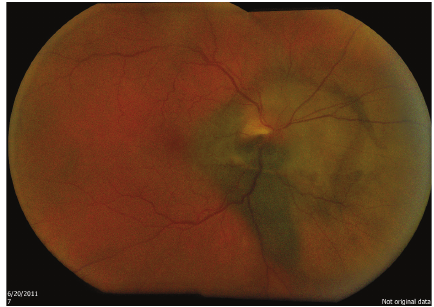
Figure 5: Fundus photograph at initial presentation upon examination.